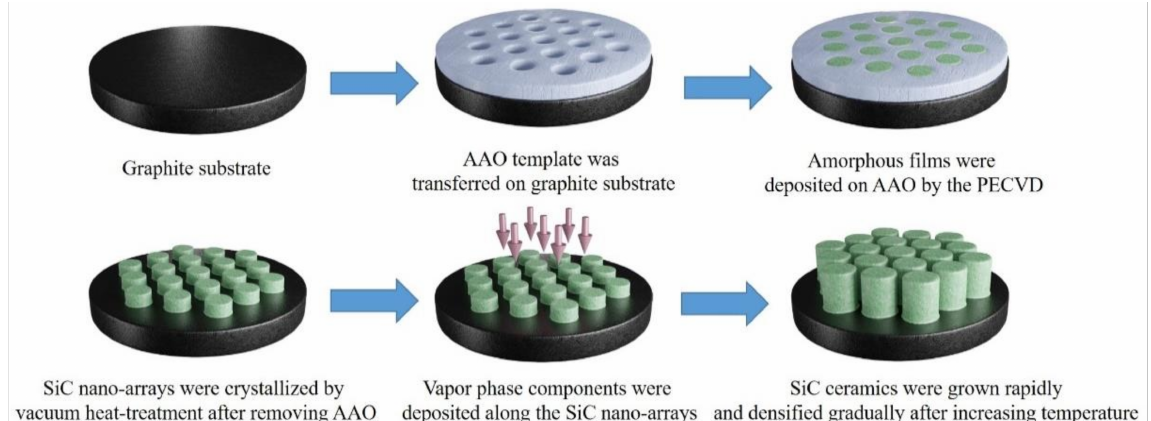
Figure 11. The schematic diagram of the regulation mechanism of nano-array seeds on the microstructure of SiC